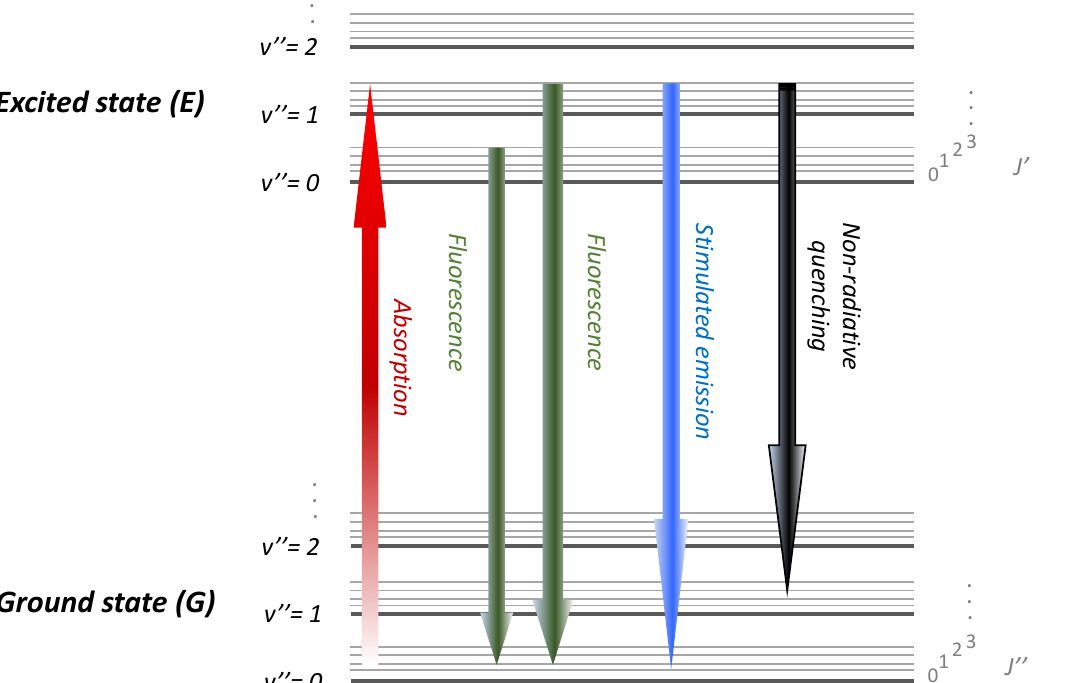
Figure 1. The primary processes observed in a molecular system when applying LIF. The system is composed from electronic ( G and E ), vibrational ( v’ and v’’ ), and rotational ( J’ and J’’ ) energy levels.